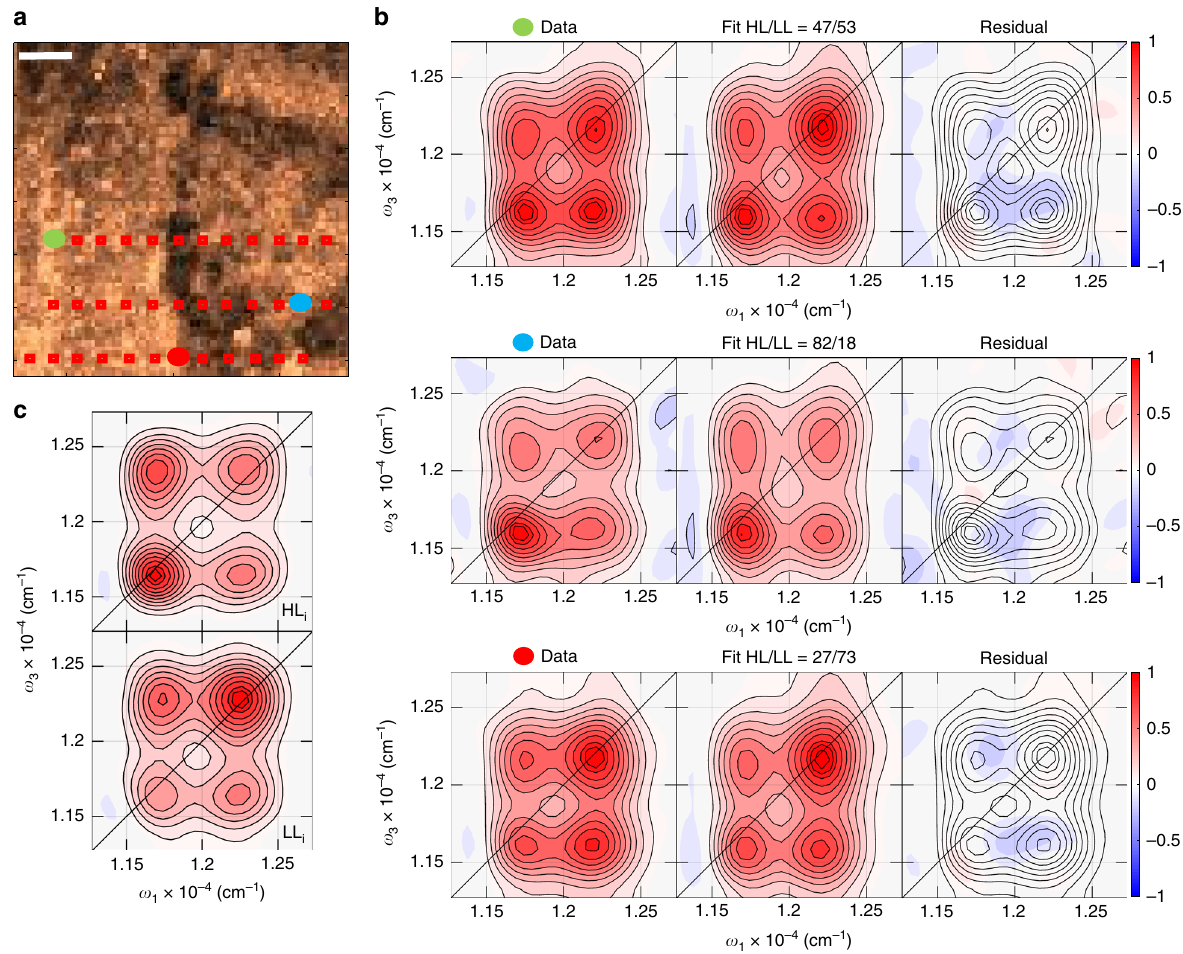
Fig. 3 SF-2DES on mixed cells of Rps. palustris grown under high and low light (HL and LL). a Confocal fl uorescence image from a mixed, LL and HL, drop- dried fi lm of photosynthetic bacteria Rps. palustris . Red squares correspond to all the locations where a 2D spectrum was collected, and is shown in Supplementary Figures 3 – 5. The red, blue and green solid dots indicate locations for which the corresponding 2D spectra are shown in panel b . A 10 μ m scale bar is shown for reference. b Normalized t 2 = 0 fs absorptive 2D spectra collected at the three solid dot locations shown on the fl uorescence image in panel a . The three horizontal frames show the measured 2D spectrum (left frame), a linear least squares fi t obtained by using the LL and HL 2D spectra (in Fig. 2b) as the basis spectra to describe the spectrum collected from a mixed sample (middle frame), and the resulting residual (right frame). All the frames in a panel are normalized to the left frame. The middle frame also displays the ratio of purely HL and LL 2D basis spectra (shown in Fig. 2b), which best fi ts the measured spectrum. c Absorptive t 2 = 0 fs 2D spectra for the HL and LL samples obtained by recirculating a live cell solution through a 200 μ m pathlength sample cell using a peristaltic pump. These spectra represent the ideal scenario (represented as LL i , HL i ), where there is no measurable photobleaching. The OD of the sample in 1 mm pathlength corresponds to that shown in Fig. 2c. Contours are drawn at 10 – 90% in steps of 10%, with additional contours at 95 and 100% to highlight small differences in maxima. The frequency ω corresponding to the axes on the 2D plots corresponds to ω = | ω ′ |/2 π c , where ω is in rad/fs. The solid black line across the 2D plot corresponds to the diagonal. All measurements were conducted at 300